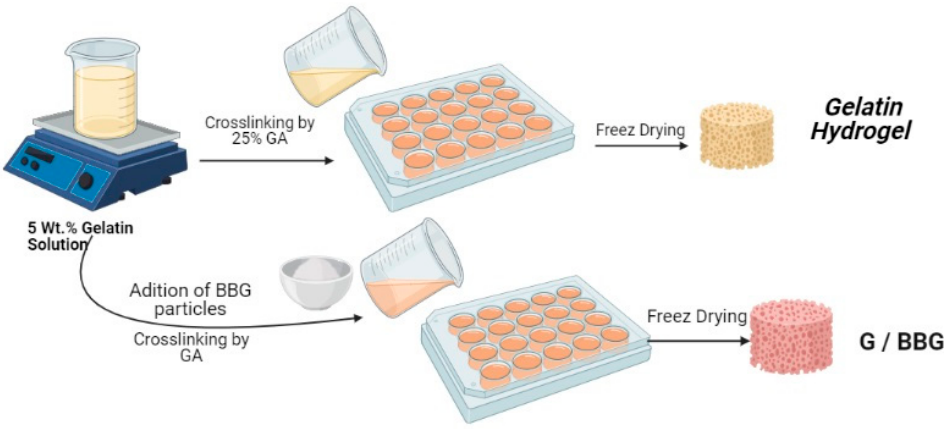
Figure 1. Detailed preparation method of gelatin/borosilicate bioactive glass